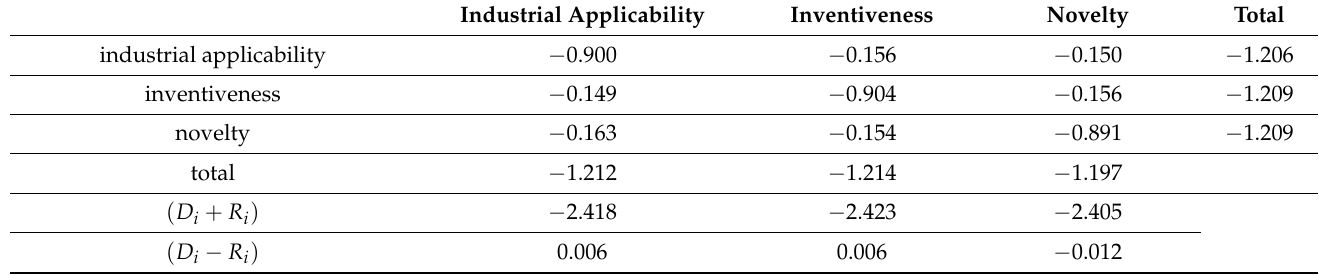
Table 6. The causal matrix of sub-aspects of essence of technology. Inventive- Industrial Applicability